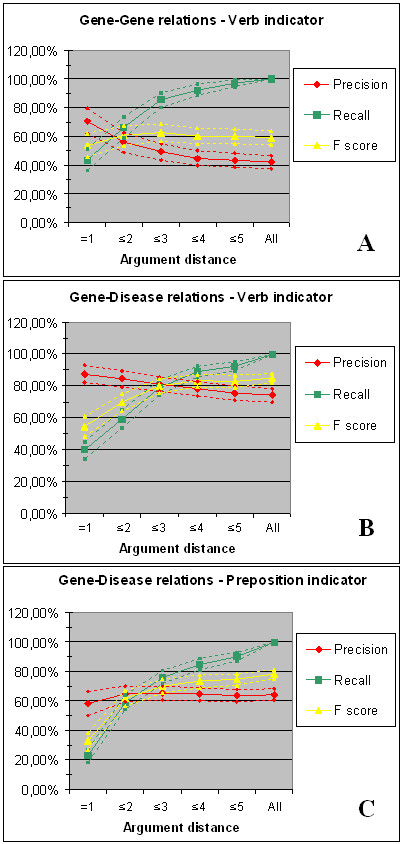
Filtering semantic relations, with official symbol for each extracted gene, at increasing argument distance. Argument distance indicates the maximum distance of each argument from the indicator in the relations retained after filtering. "All" refers to no filtering. Precision (P), Recall (R), and F score (F) were calculated as follows: P = rc/(rc+ri), R = rc/(rc+dc), F = 2*P*R/(P+R) with rc the retained correct relations, ri the retained incorrect relations, and dc the discarded correct relations. Dotted lines indicate limits of 95% confidence intervals.